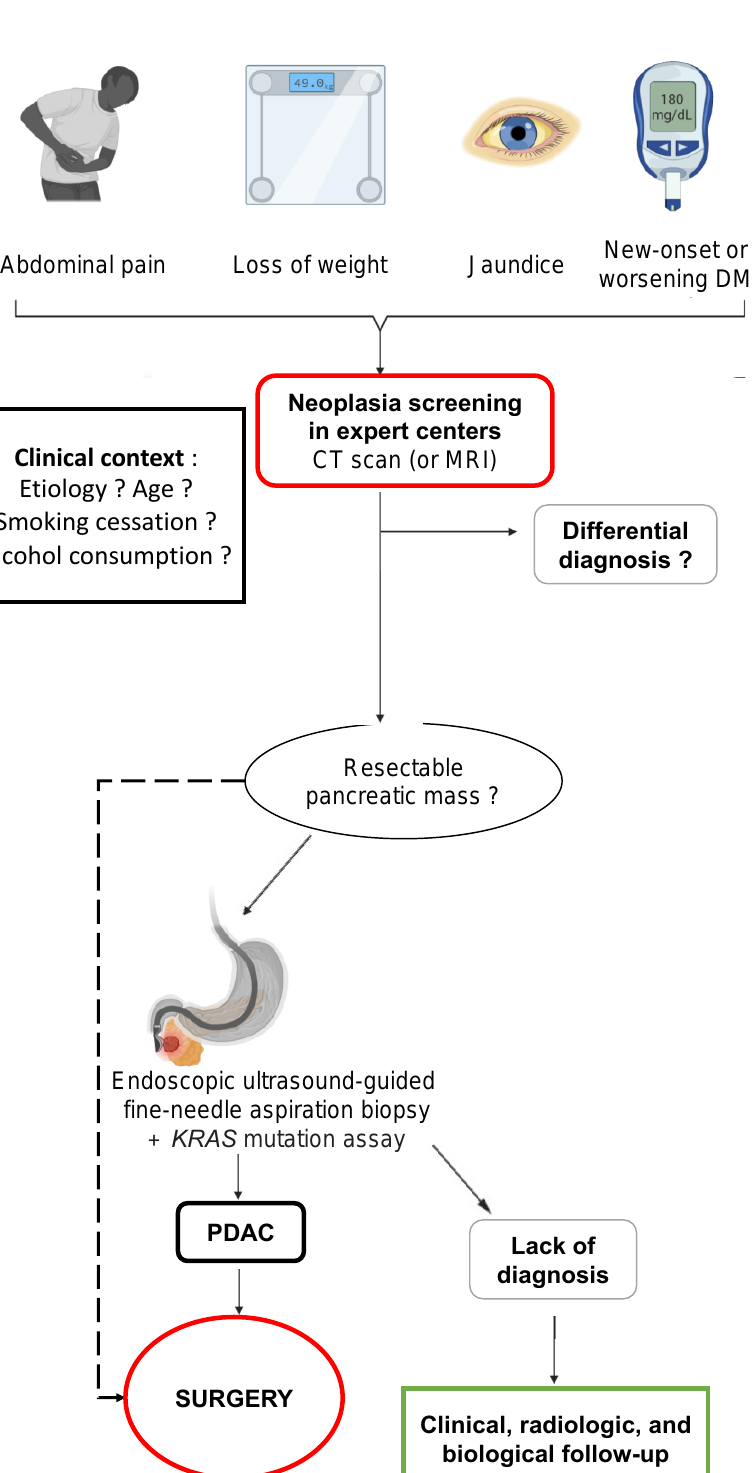
Figure 6. Proposed screening algorithm for pancreatic ductal adenocarcinoma in patients with chronic pancreatitis. DM: diabetes mellitus; CT scan: computed tomography scan; MRI: magnetic resonance imaging; PDAC: pancreatic ductal adenocarcinoma.